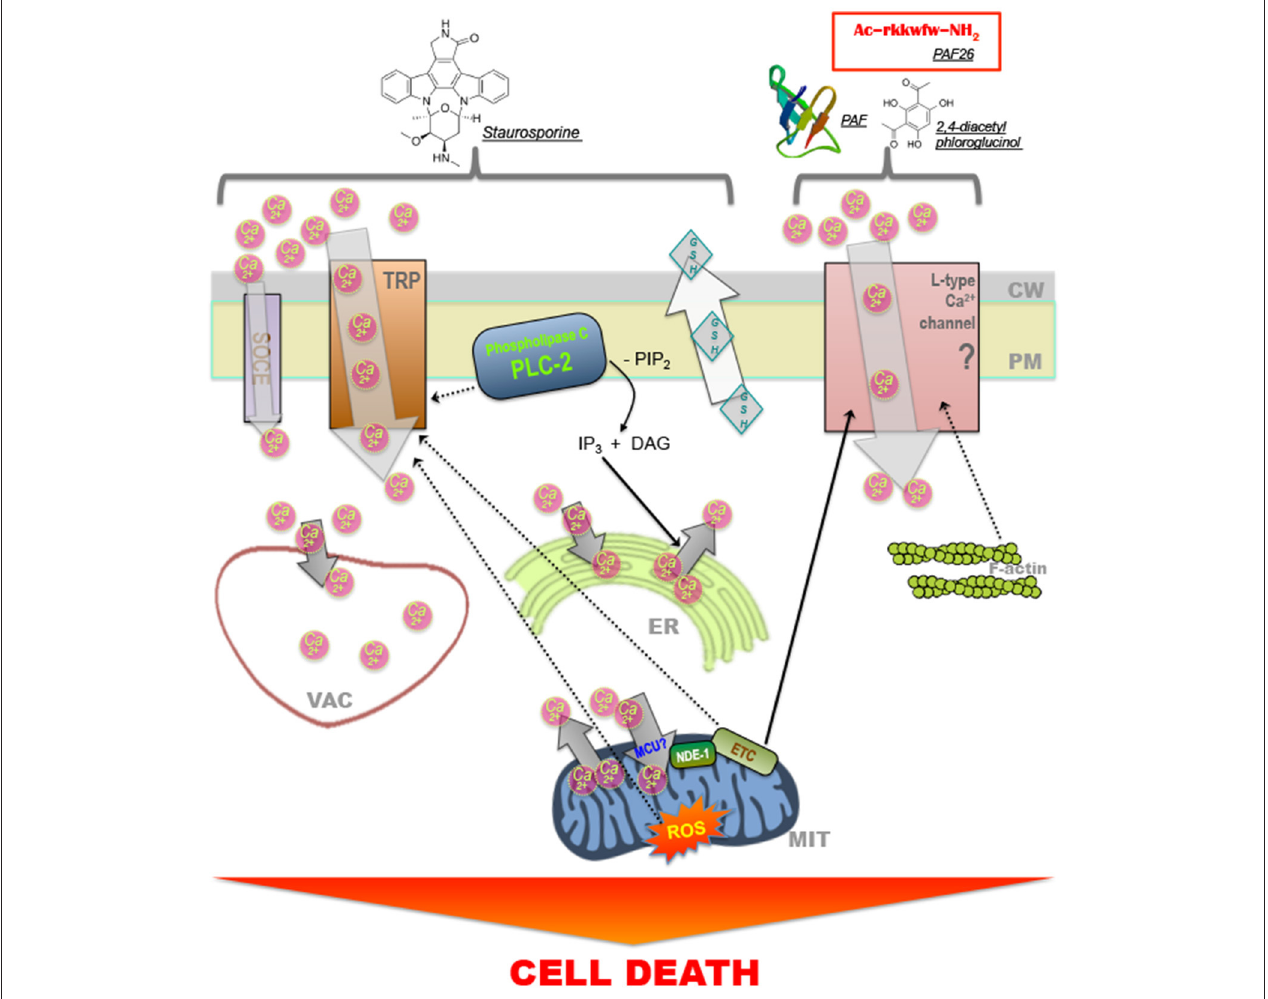
FIGURE 2 | Model for Ca 2 + transport and signaling involved in cell death in filamentous fungi. Model for staurosporine induced modifications in intracellular Ca 2 + dynamics that precede induction of cell death in N. crassa (Goncalves et al., 2014a). The phospholipase C-family protein PLC-2 plays a pivotal role during the process, which occurs via the recruitment of Ca 2 + from the extracellular space, through a TRP-like channel via store-operated Ca 2 + entry (SOCE) and from internal stores such as the endoplasmic reticulum (via a IP 3 -activated channel) or the mitochondria; ROS formation is necessary for the recruitment of Ca 2 + to the